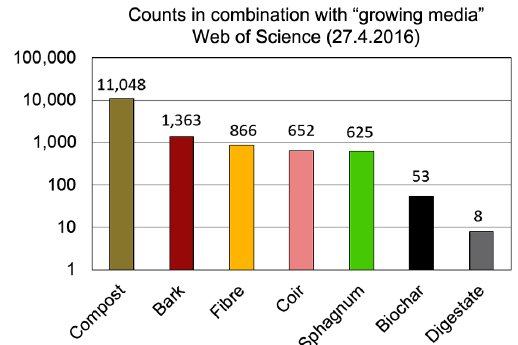
Fig. 3. Overview about the main components in growing media and their corresponding number of related publications listed in the Web of Science in April 2016